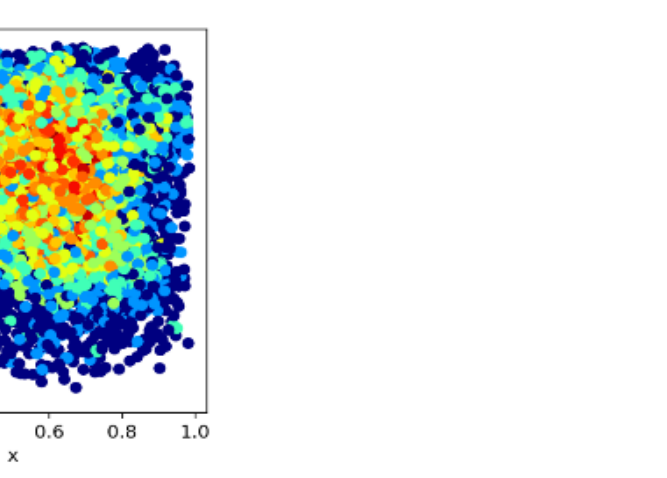
Figure 10. Heat map of the distribution of fish positions. Each individual fish represents a point in the figure, and the color is darkened if multiple fish appear in the location, i.e., as the color becomes redder, the possibility of fish in the area becomes higher.